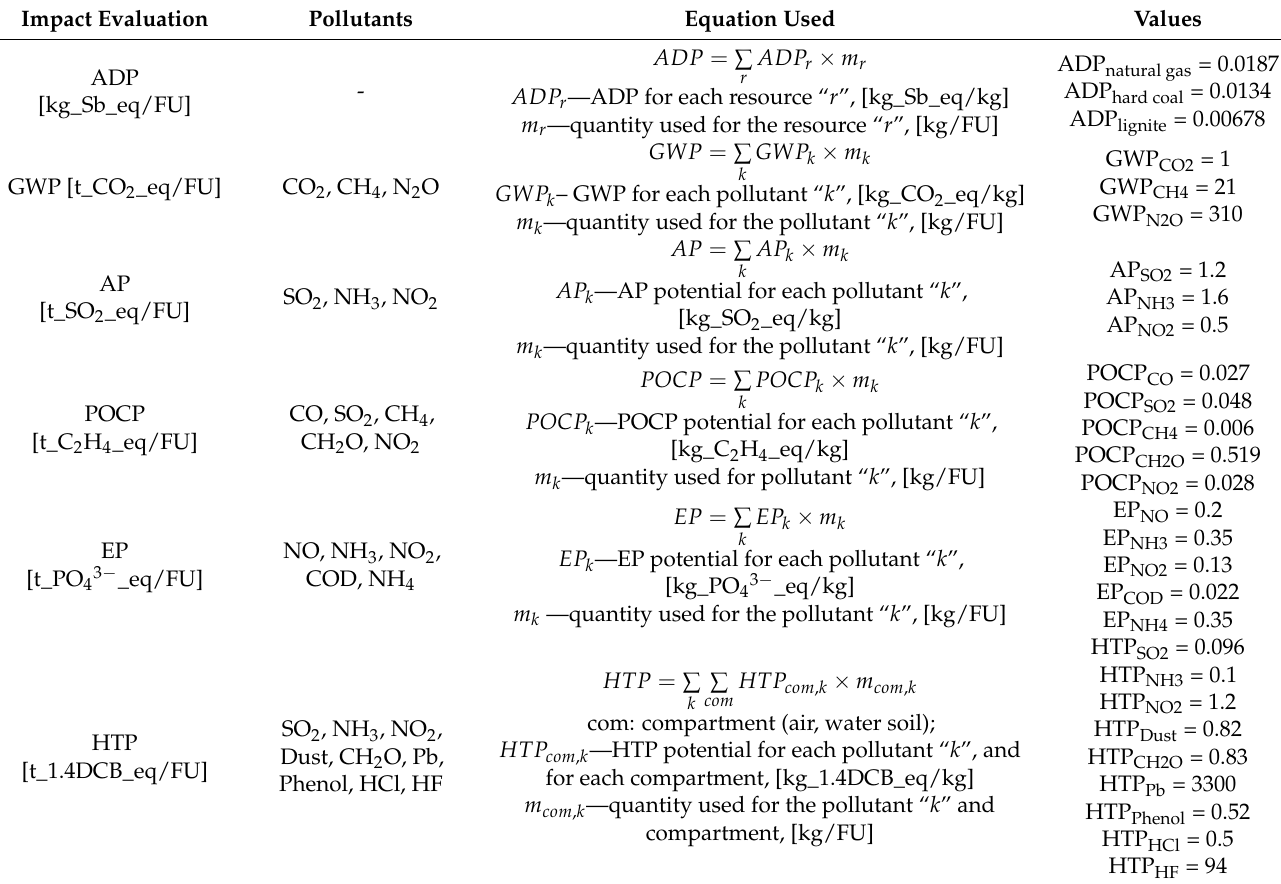
Table 5. Classification and quantification of emissions [41].